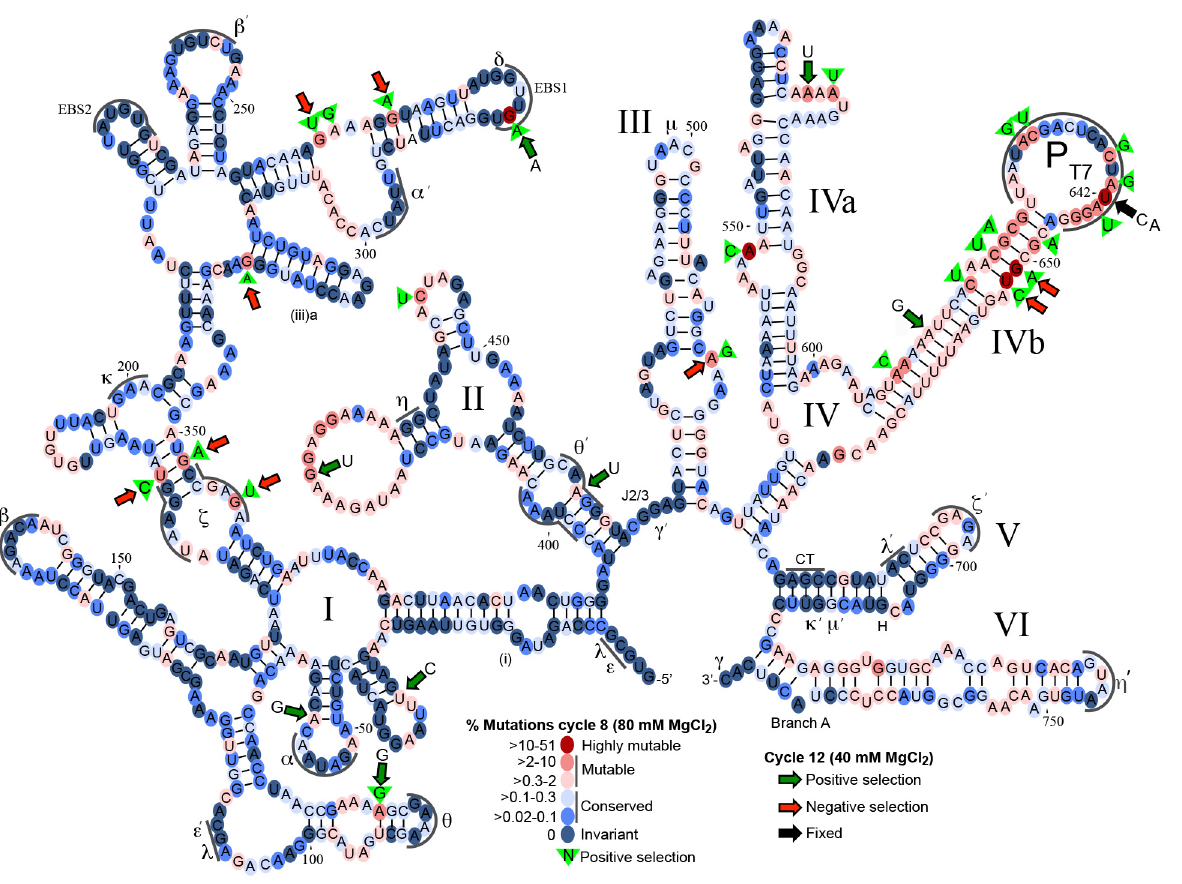
Fig 7. Mutational fitness map of the Ll.LtrB intron during directed evolution in human cells. Secondary structure diagram of the Ll.LtrB intron showing mutation frequencies based on Pacific Biosciences RS circular consensus sequencing after 8 and 12 cycles of directed evolution in HEK-293 cells in culture medium supplemented with 80 mM or 40 mM MgCl 2 . Round 8 was assessed with 1,395 full-length reads, with the results presented as a color-coded heat map on a secondary structure diagram of the Ll.LtrB intron. Dark to light blue ovals represent conserved nucleotide positions with mutations present in 0 – 0.3% of the population. Pink to red ovals indicate mutable nucleotide positions with mutations present in > 0.3 – 60% of the population. Green triangles with nucleotide inscribed, indicate positive selection in rounds 1 – 8 with the indicated nucleotide comprising > 80% of the mutations at that position. Round 12 was assessed with 3,069 full-length reads with large colored arrows indicating positions at which the indicated mutation increased (green arrows) or decreased (red arrows) in frequency by > 2-fold in round 12 after selection at 40 mM Mg 2+ relative to round 8 after selection at 80 mM Mg 2+ . The black arrow at position 642 indicates that the mutations shown at this position were fixed in 99% of the population in round 12. Greek letters with sequence delineated below indicate motifs involved in long-range tertiary structure